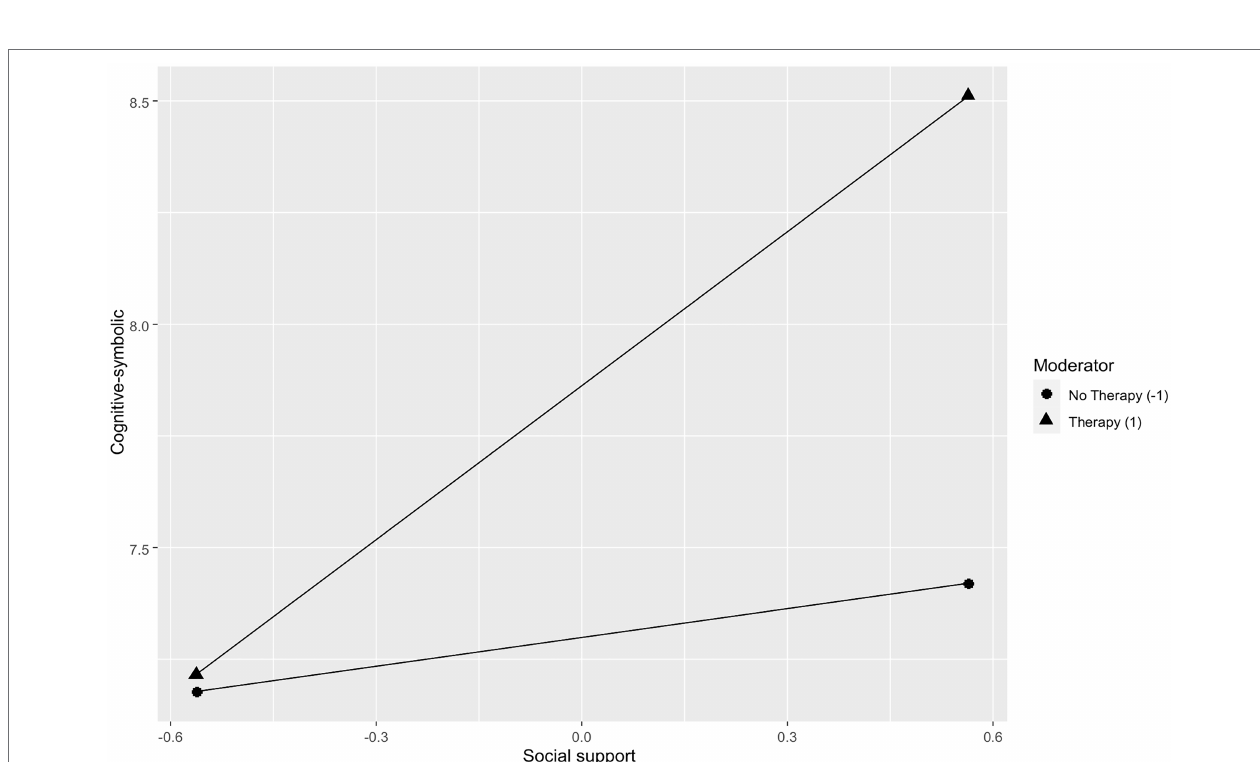
FIGURE 1 | Simple slope showing the role of psychotherapy as moderator in the relationship between cognitive-symbolic and avoidance.